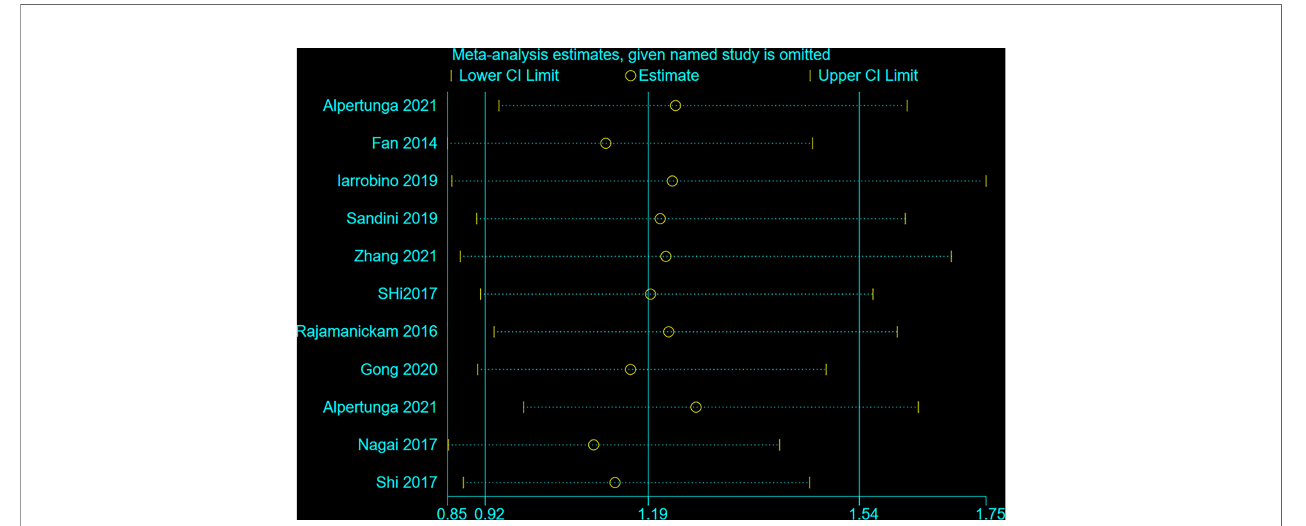
FIGURE 6 | Sensitivity analysis of overall survival according to blood glucose